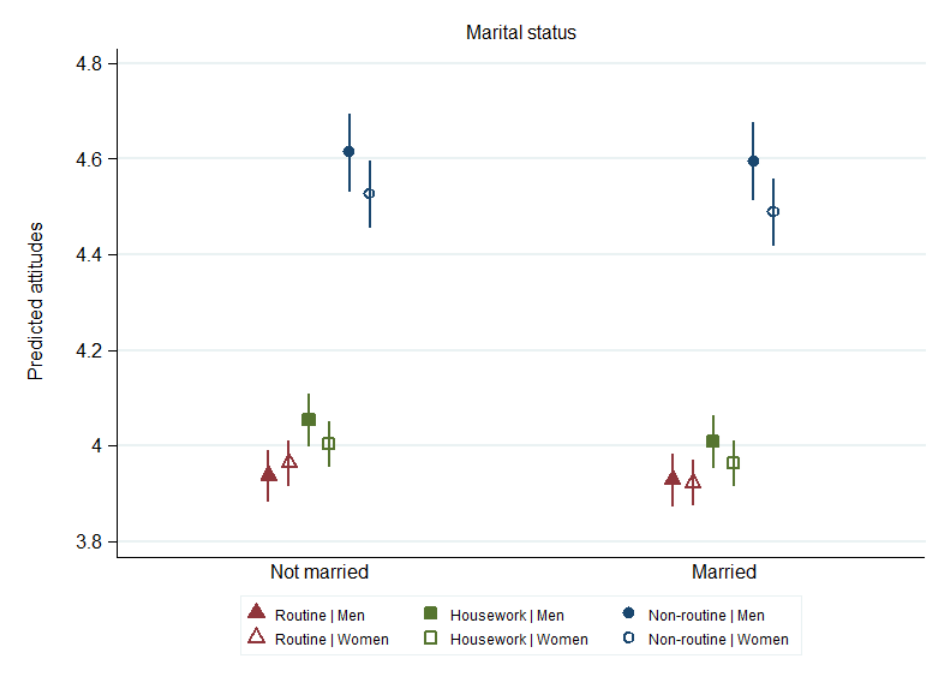
Predicted attitudes towards housework by vignette couples’ marital